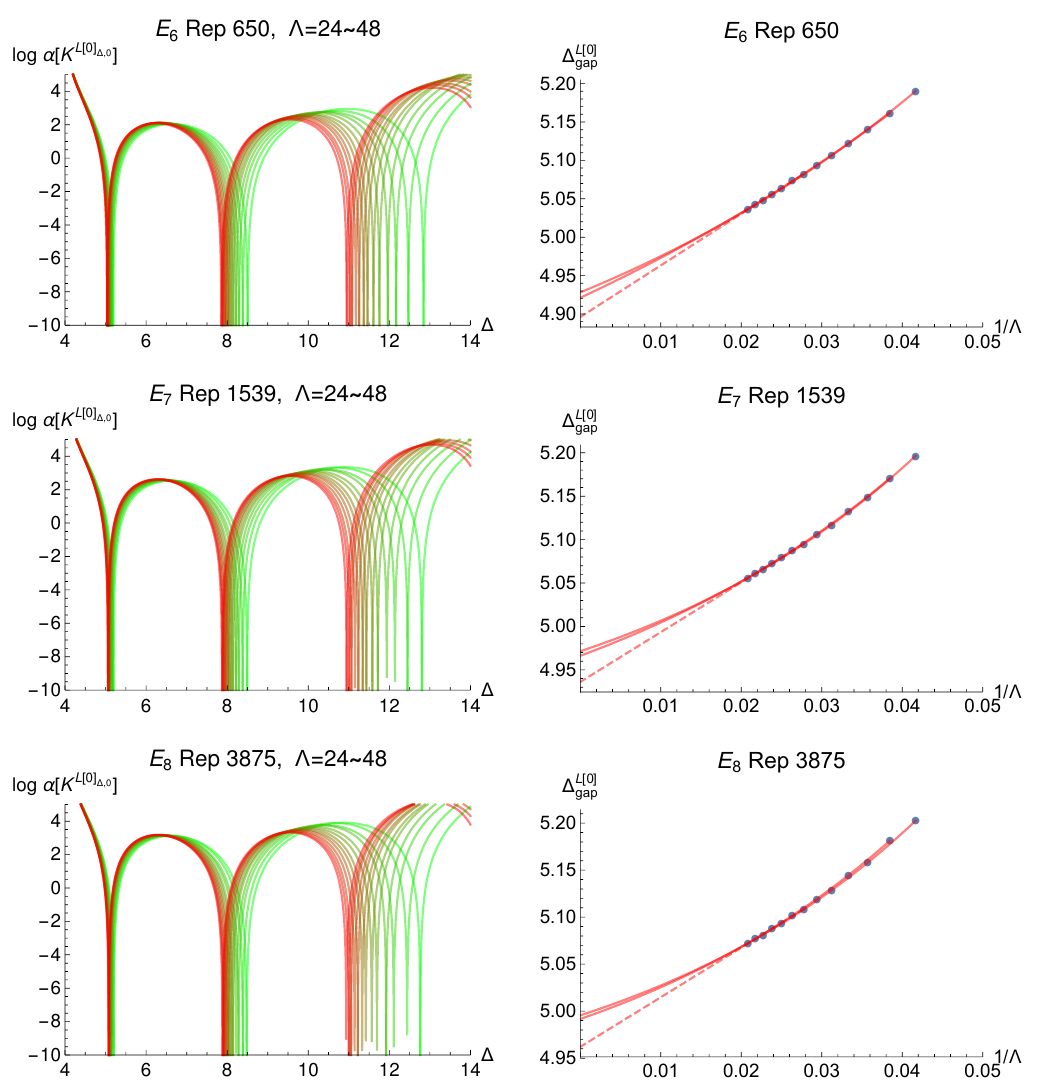
Figure 11. Left: the extremal functional optimizing the lower bound on C J , acted on the contri- bution of the spin-zero long multiplet to the crossing equation, (cid:11) [ K L [0] (cid:1) ; 0 ], in the 650 of E 6 , D [2] ; adj the 1539 of E 7 , and the 3875 of E 8 , plotted in logarithmic scale. These representations are chosen because they have the smallest gap (the lowest scaling dimension). Increasing derivative orders (cid:3) = 24 ; 26 ; : : : ; 48 are shown from green to red. Right: the gap at di(cid:11)erent (cid:3), and extrapolations to (cid:3) ! 1 using the exponential ansatz (5.23) for (cid:3) 2 4 Z and (cid:3) 2 4 Z + 2, separately (solid), and using the linear ansatz (5.23)